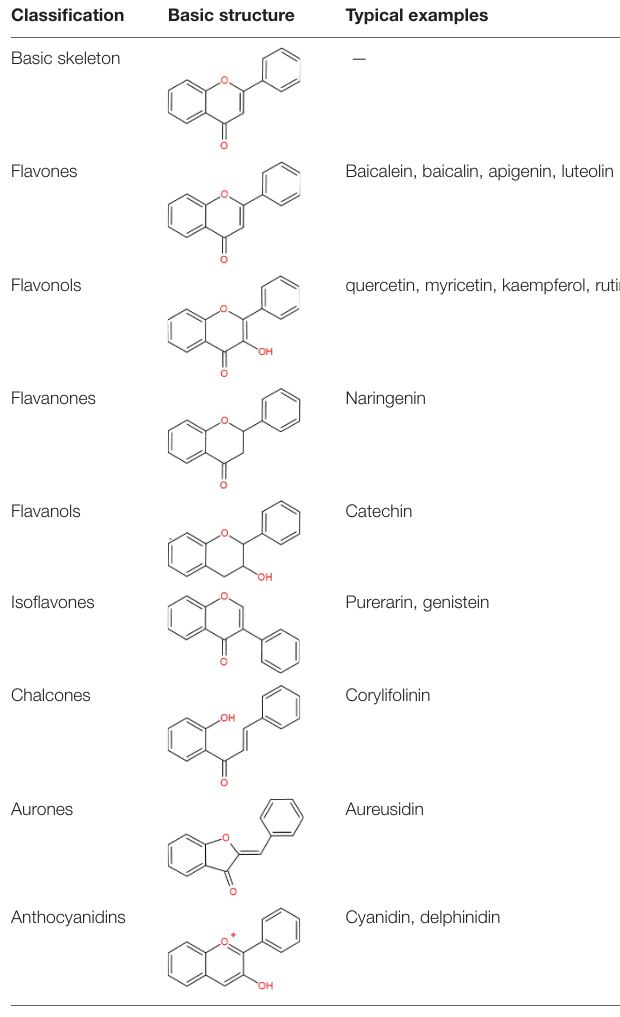
TABLE 1 | Classification of